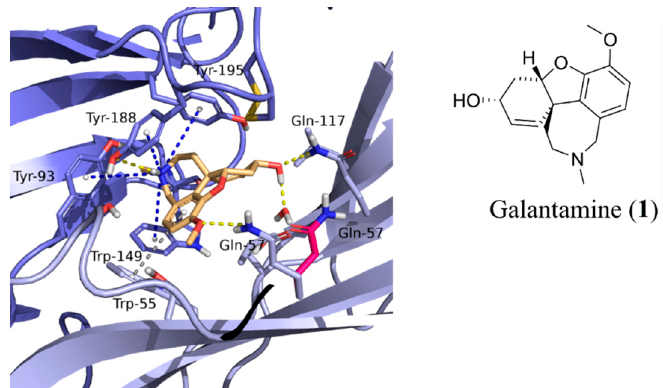
Figure 6. Interactions of galantamine (orange) in the binding pocket of homology models of the α 7 nAChR. Interacting residues are shown as purple sticks. Q57 in alternative rotameric state is shown in magenta. Galantamine creates three hydrogen bonds with Q57, Q117, and Y188 (yellow dotted lines) along with several aromatic contacts with the principal receptors: Y93, W149, Y188, and Y195 (blue dotted lines) and to W55 on the complementary side (grey dotted line).